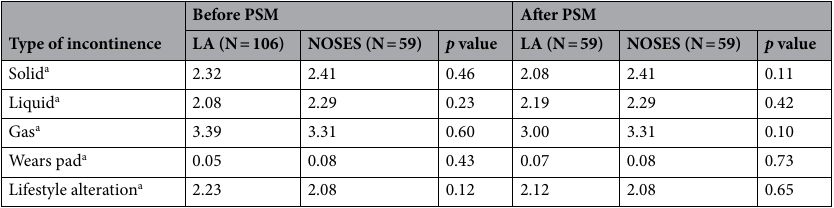
Table 4. Postoperative Wexner scores in both groups. a Mean.